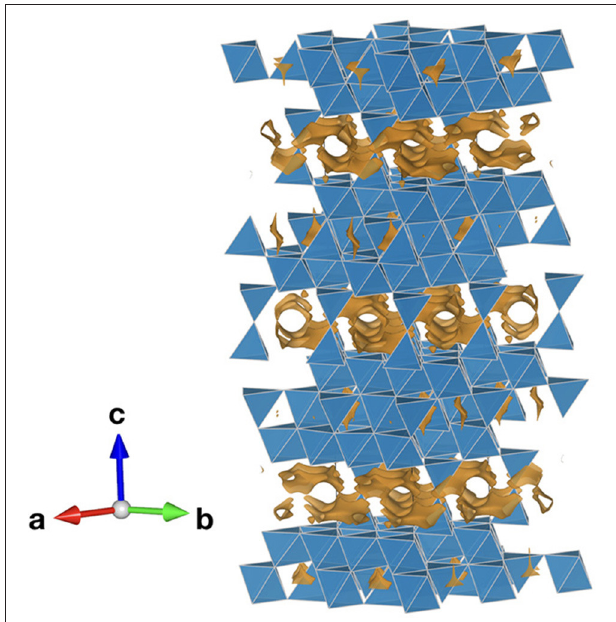
FIGURE 6 | Bond valence energy landscape (orange) of Al 3 + in Na + - β ”-alumina with Na being removed and the Al kept for the calculation (Al 10.35 Mg 0.65 Na 1.65 O 17 , ICSD #6326592) drawn at the energy threshold of 1.07eV. Blue polyhedra denote AlO 6 /AlO 4 /MgO 4 octa- or tetrahedra. The calculations were performed according to Nestler et al. (2019b) using the program softBV (Adams and Rao,